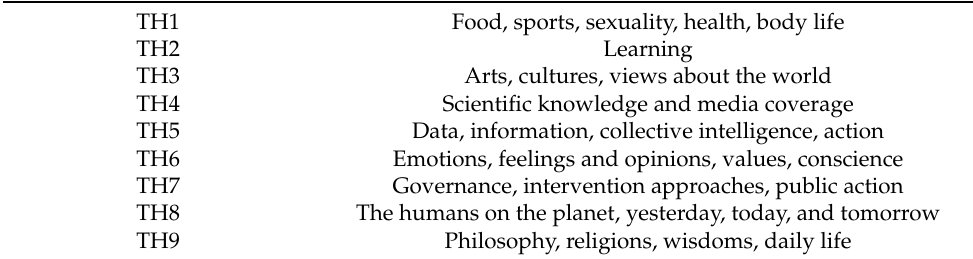
Table 1. The 9 topic hubs for the Garden-party